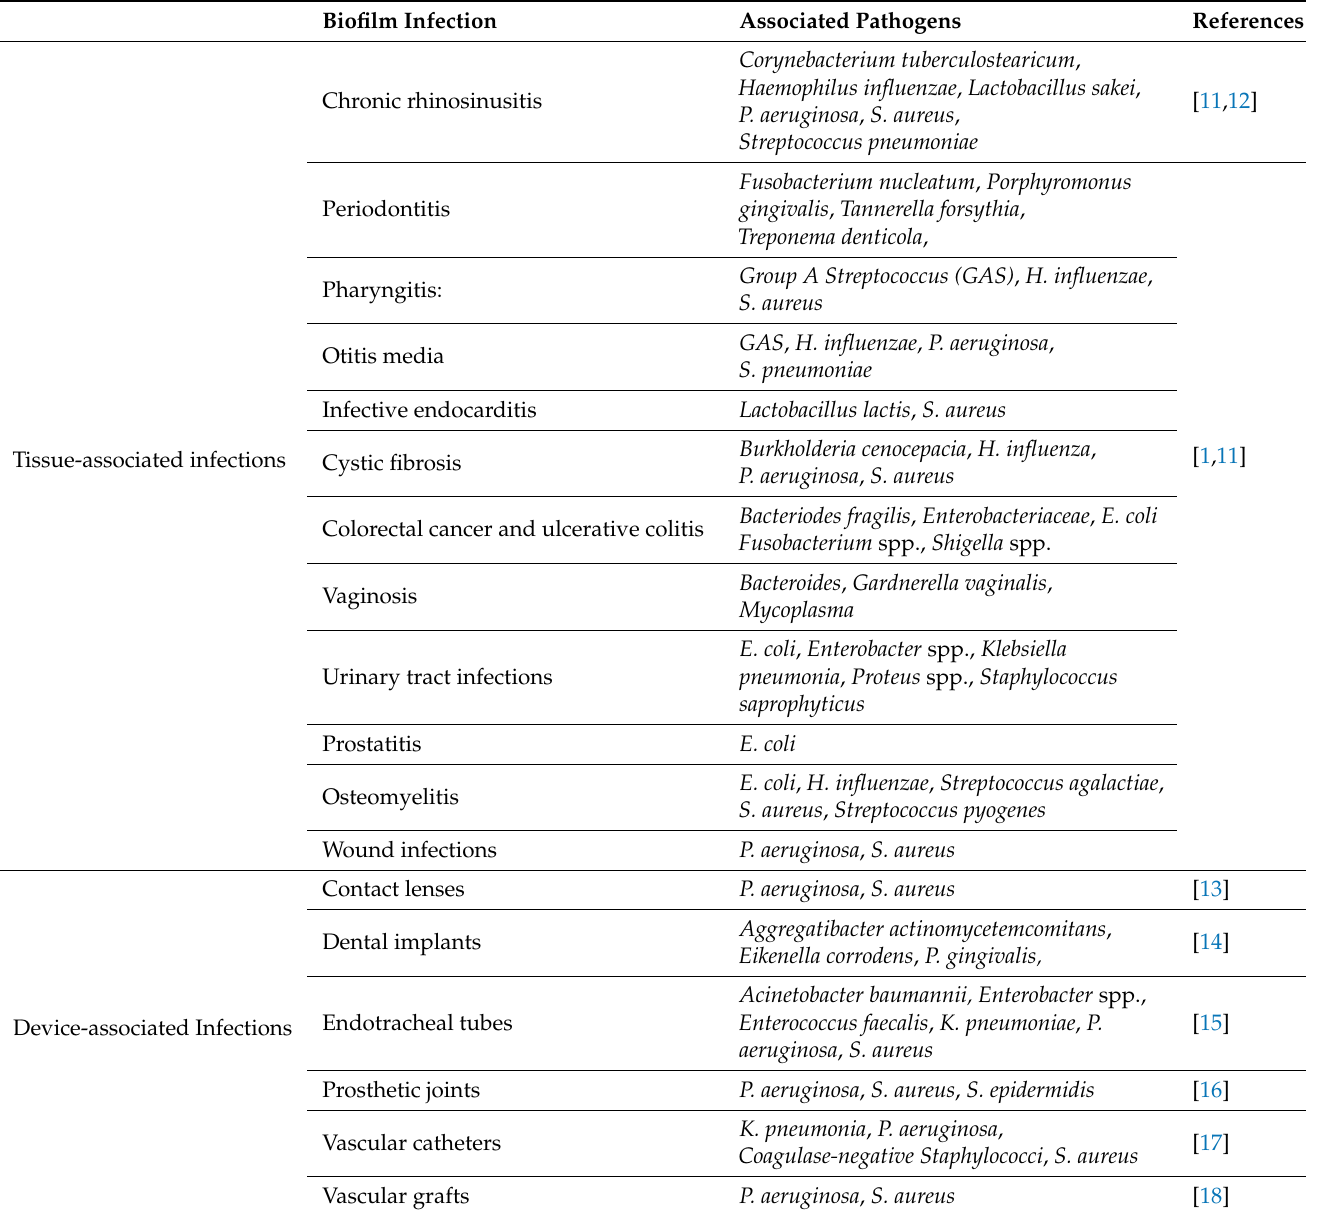
Table 1. Major tissue and device-associated biofilm